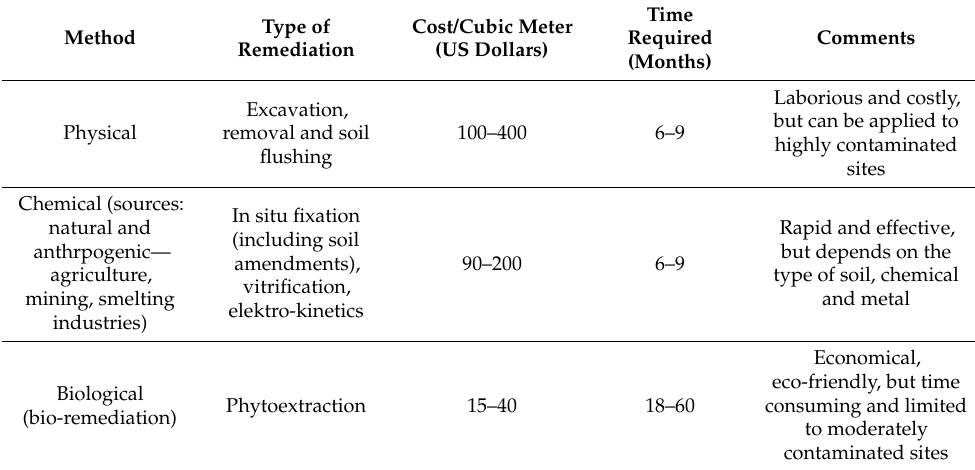
Table 6. Comparison of different methods of heavy-metal soil remediation (adapted from Schnoor [67]) (relative costs as during